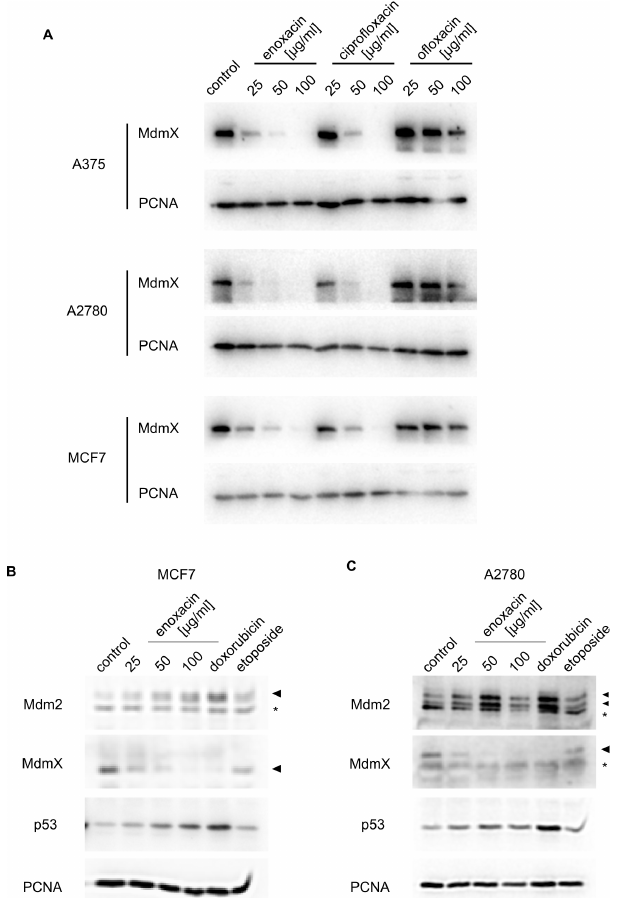
Fig 5. Enoxacin promotes MdmX downregulation in different cancer types. ( A ) Western blot analysisof changesin cellularMdmX protein levels inducedby 24 h treatment with three fluoroquinolone drugs at indicatedconcentrations in A375 melanoma,A2780 ovariancarcinoma,and MCF7 breast carcinoma.PCNA served as a loadingcontrol. ( B )( C )Western blot analysisof changesin cellularMdmX, Mdm2, and p53 protein levels inducedby 24 h treatment with enoxacinand DNA damaging agents. PCNA served as a loading control. (B) MCF7, (C) A2780, * non-specific band.